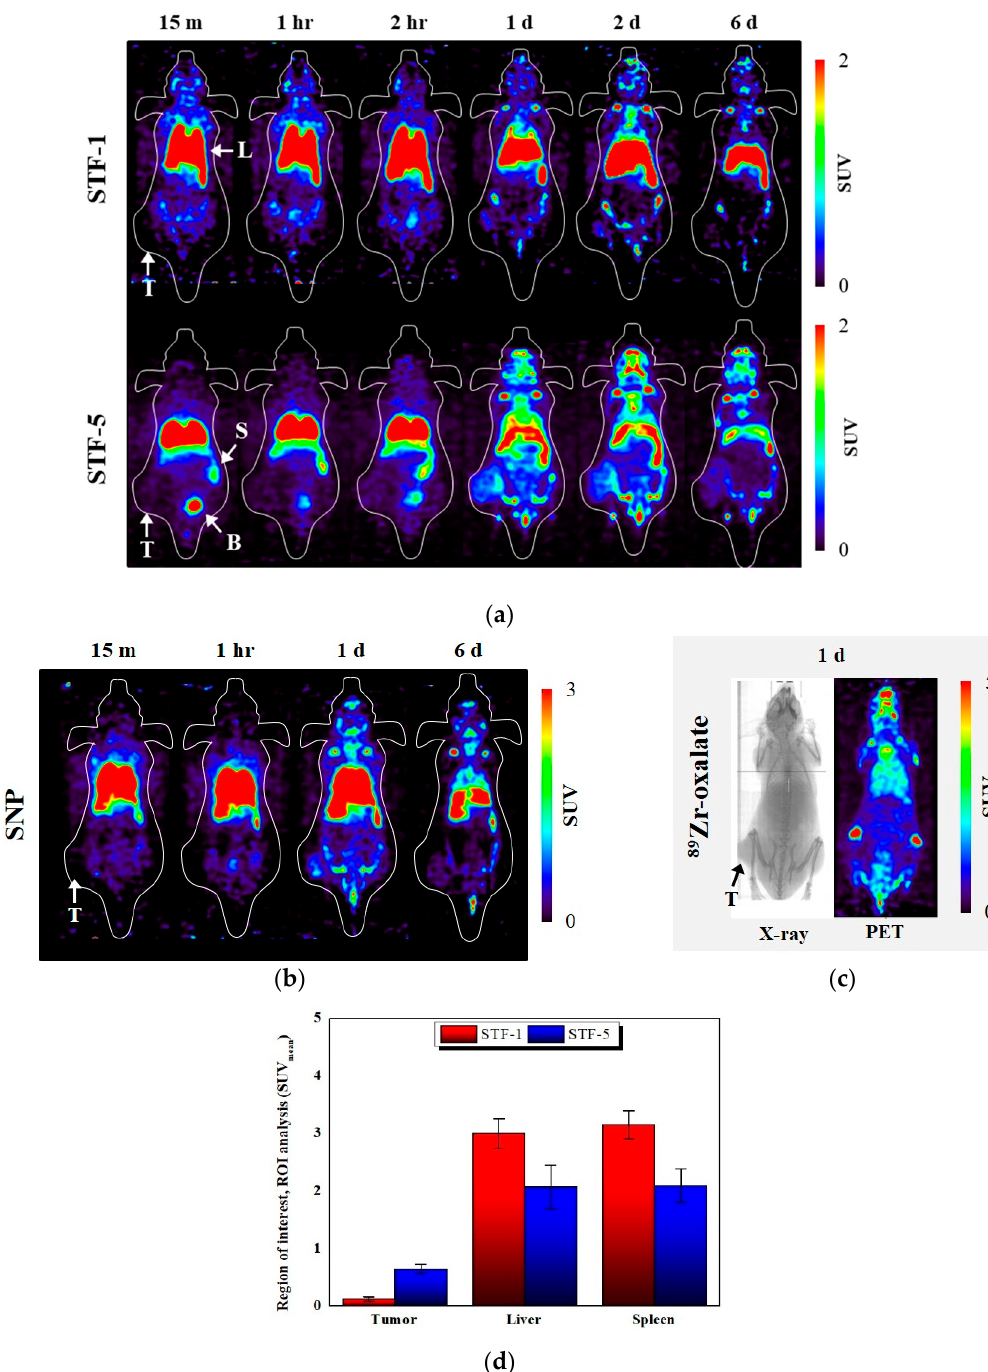
Figure 6. Positron emission tomography (PET) study results of CT-26-bearing 5-week-old female Balb/c mice. CT-26 xenograft mice were scanned for a 5-min static image at time points after intravenous injection of ( a ) 89 Zr-STF-1 and 89 Zr-STF-5; ( b ) 89 Zr-SNP; ( c ) 89 Zr-oxalate; T: tumor, L: liver, S: spleen, B: bladder; ( d ) ROI analysis of STF-1 and STF-5 one day after injection.